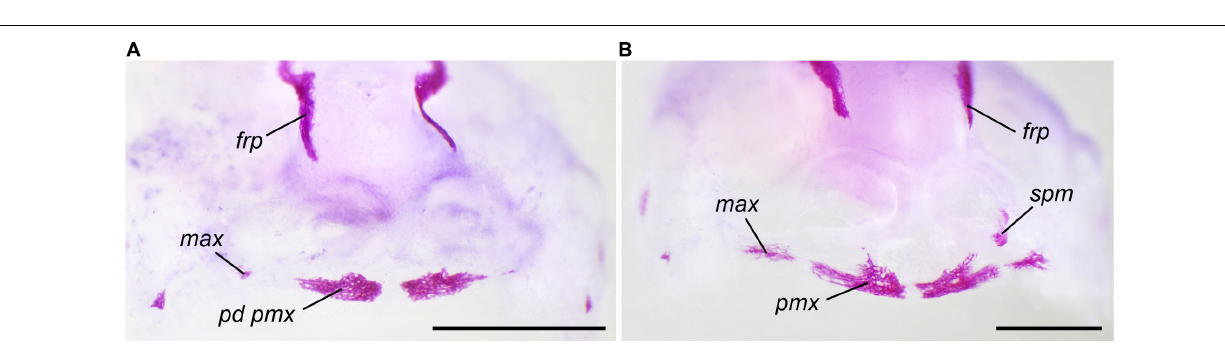
FIGURE 4 | Development of the premaxilla and maxilla in Bombina variegata at T 3 2 × 10 − 8 M (late): (A) Stage 36, 22 dph (B) Stage 37, 24 dph. For abbreviations, see Figures 1 , 2 . Scale bar 1